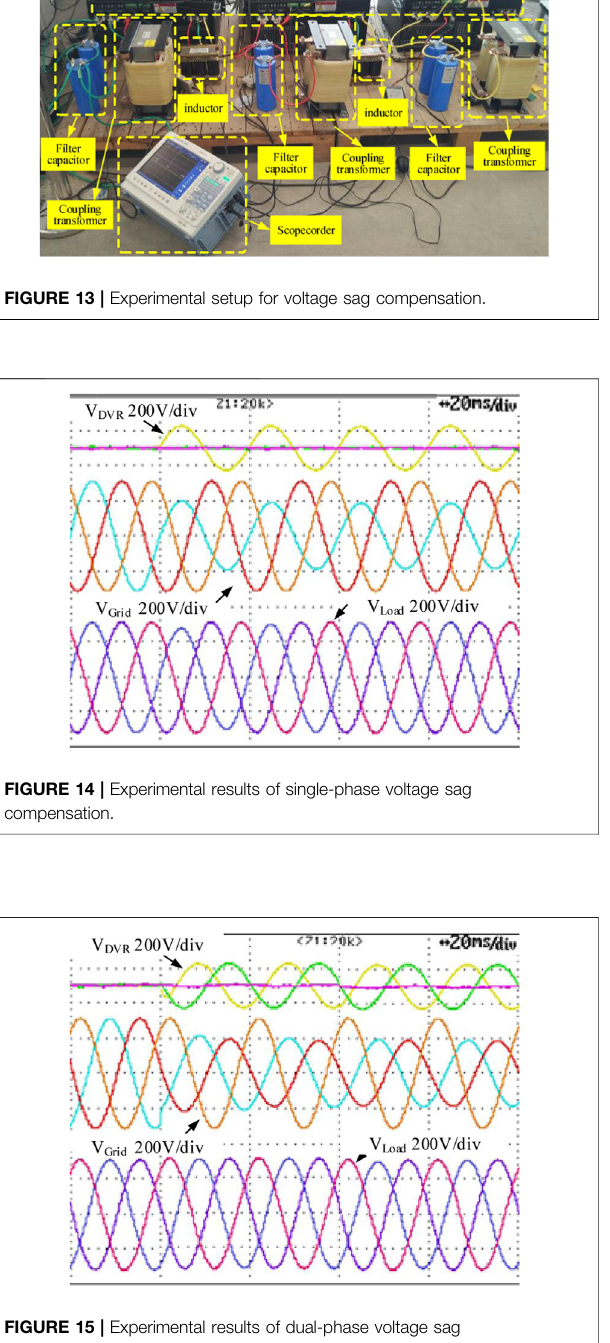
In Figure 12 , the simulation results for the single-phase, dual- phase, and three-phase voltage sags of 40% are illustrated, where the grid-side voltage, the load-side voltage, and the DVR voltage are represented as V Grid , V Load , and V DVR , respectively. It can be noted